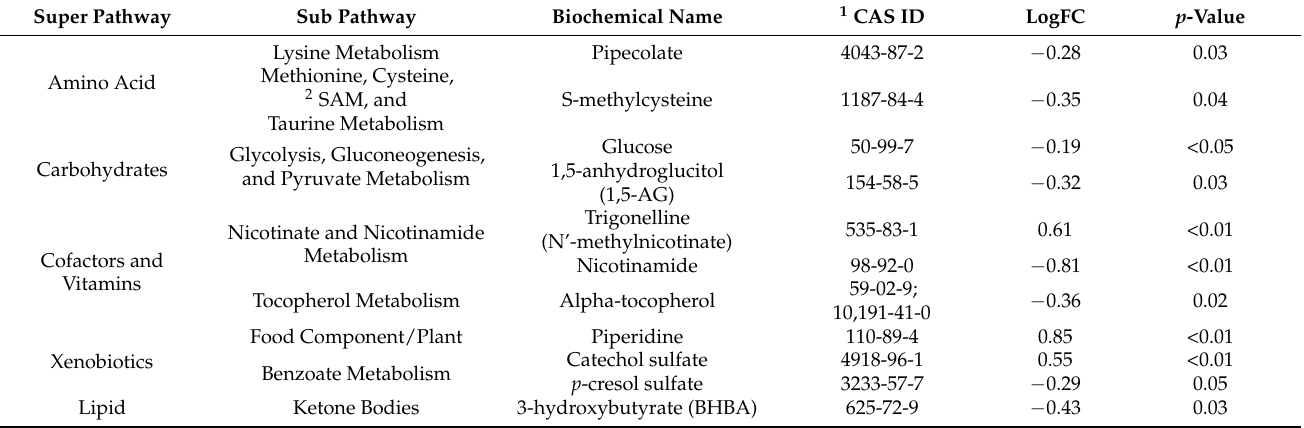
Table 5. Metabolites that were detected in the milk of cows consuming plantain and ryegrass with genetic merit (milk urea nitrogen breeding values) controlled for as a covariate that was classified as phytochemical metabolites using the Indian Medical Plants, Phytochemistry and Therapeutics (IMPPAT) curated database. Log fold change (LogFC) values are calculated with the PL diet as the reference group.